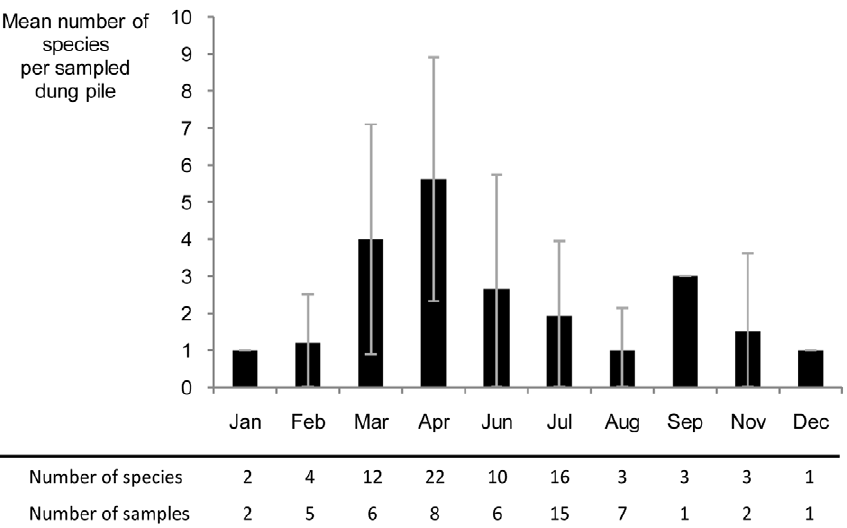
Figure 3. Seasonality of fruit variety in tapir dung. Error bars represent the standard deviations of the numbers of fruit species found in dung piles each month.